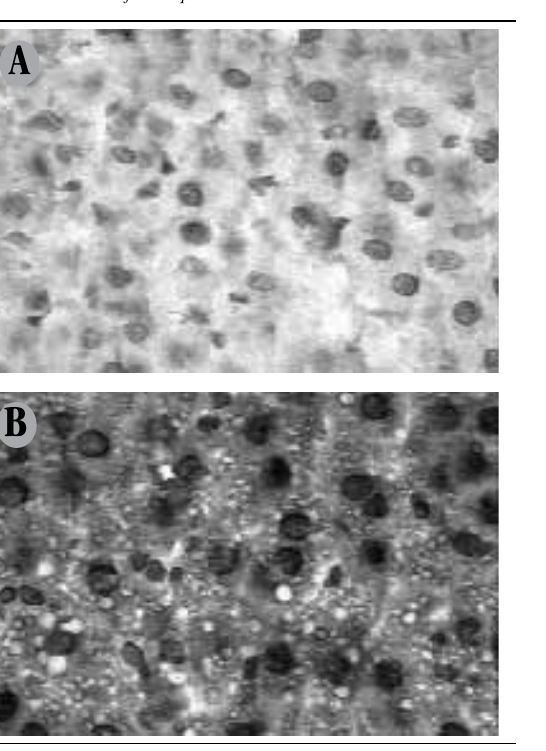
figurE 6 – Pattern of cytoplasmic immunostaining for liver iNOs A) in the control group with scarce cytoplasmic staining (400×); B) intense and diffuse reaction associated to steatosis in the group on the high-fat diet (400×). iNOS: inducible nitric oxide